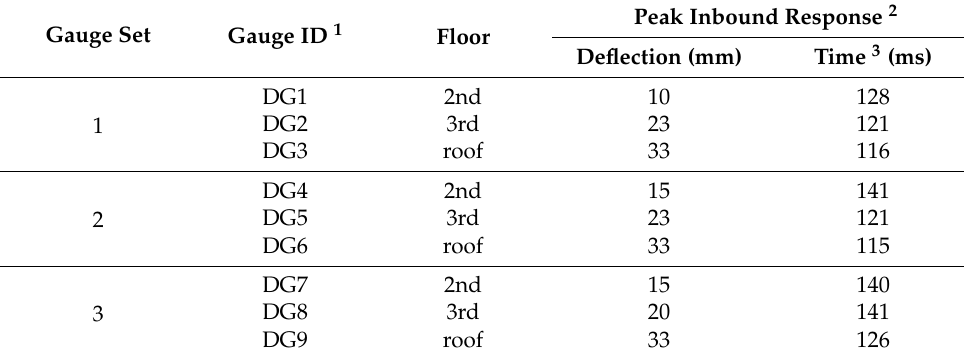
Table 1. Test 1—Measured peak inbound lateral deflection of the frame.